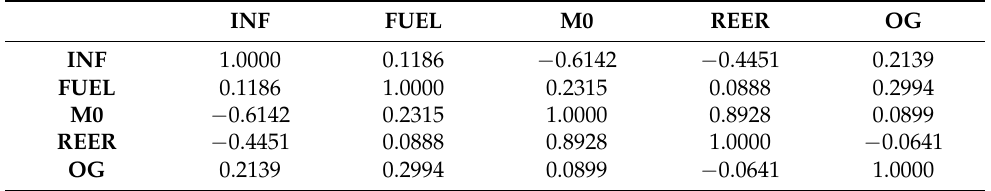
Table A2. Correlation Matrix.